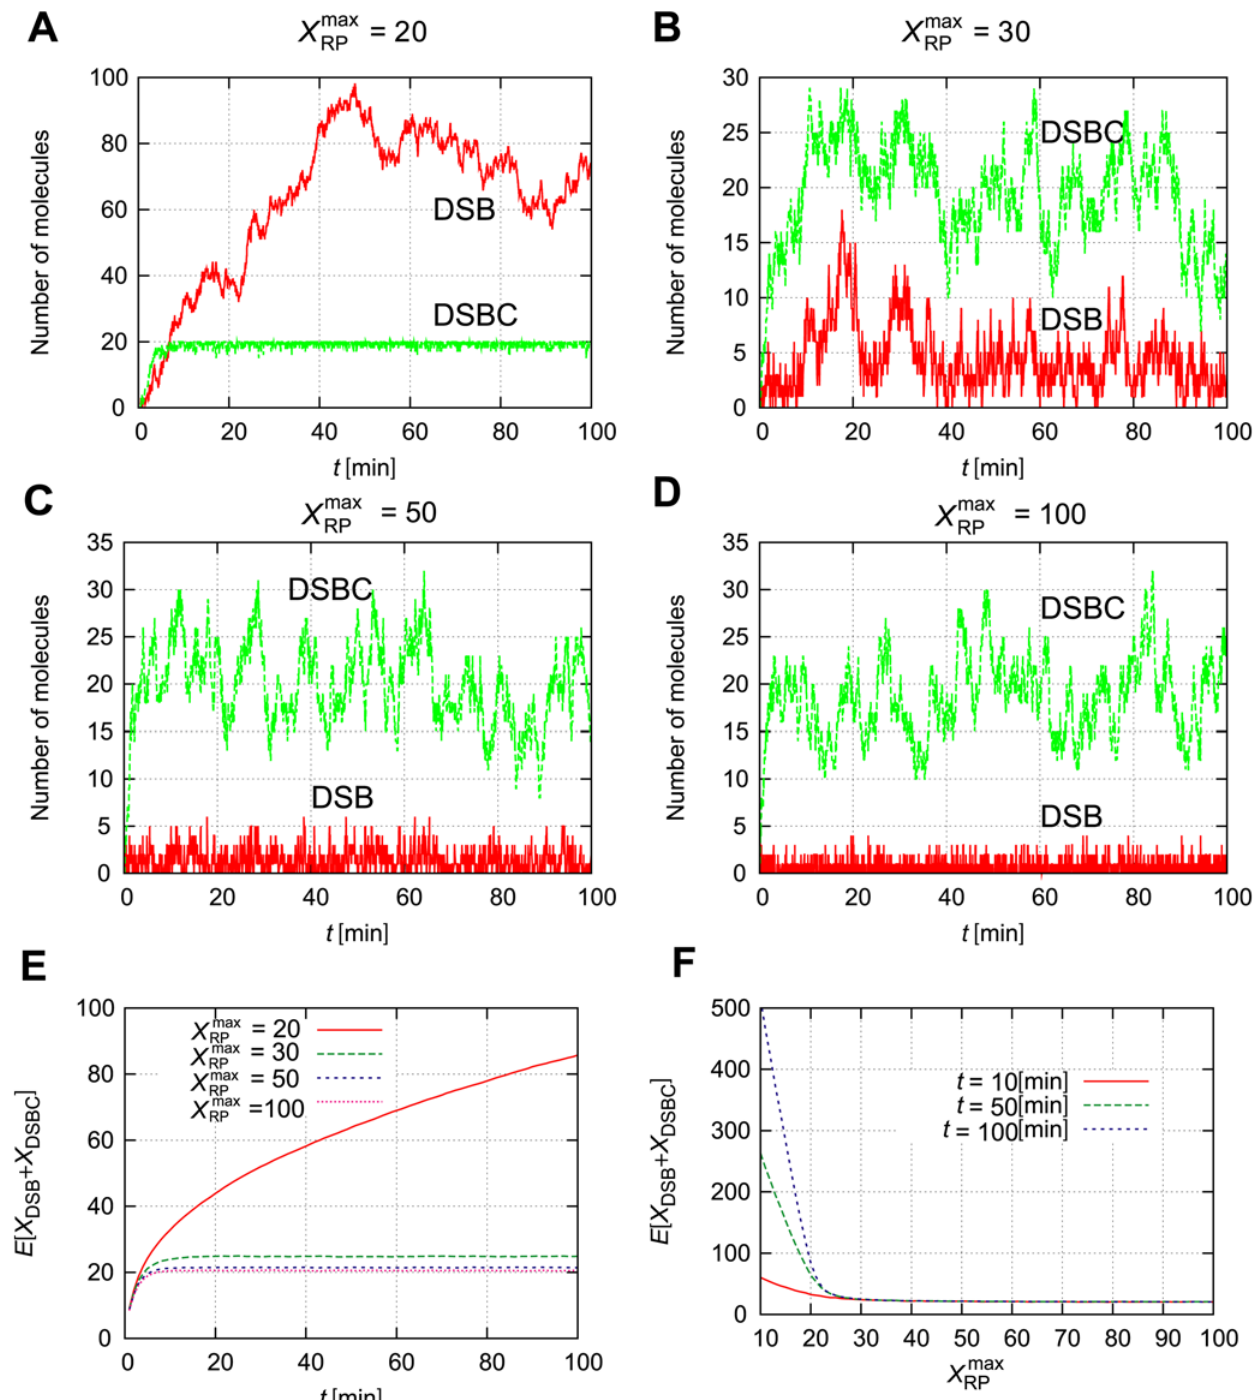
Figure 4. Small differences in X max with several values for the maximum number of repair proteins X max expectation values for several times t . Other parameters are as defined in Table 1. Initial numbers of molecules are X 0 ~ X max X 0 . RP RP